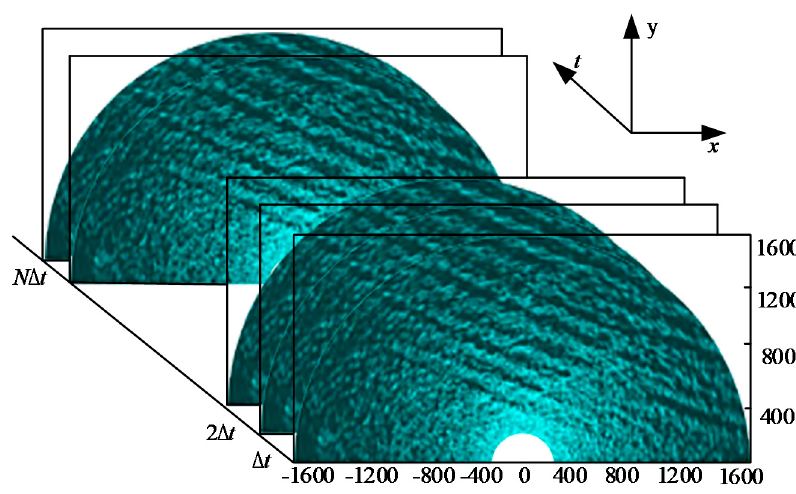
Figure 4. Time-accumulated images of X-band radar.